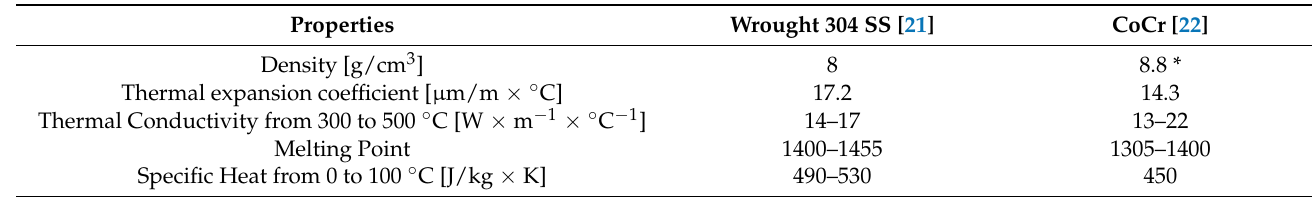
Table 1. Thermal properties of 304 SS and